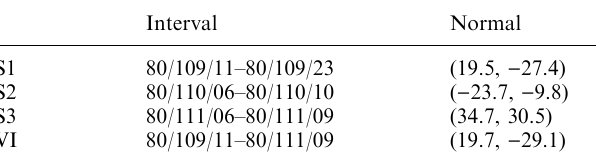
Table 2. MVA results from the multiple current sheets at Venus of no. 5 in Table 1. The coordinate of normals here is VSO Interval